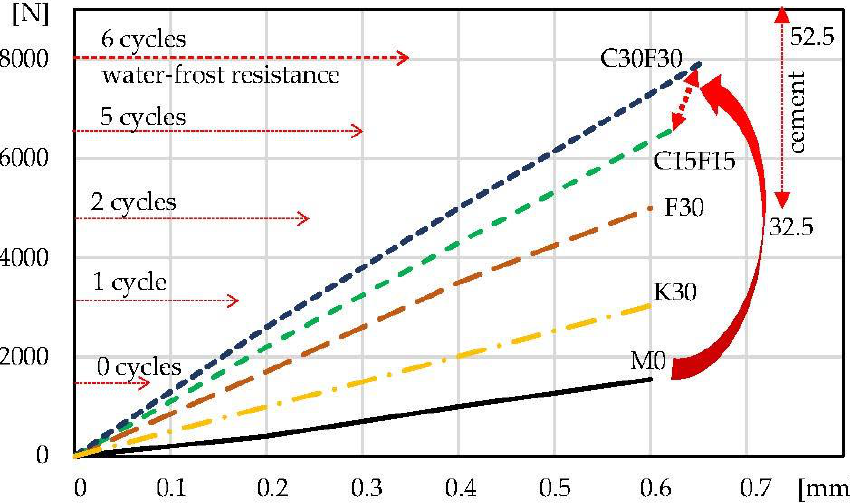
Figure 7. Load – displacement of crosshead curves: lime mortars during compression f c with water – frost resistance results.